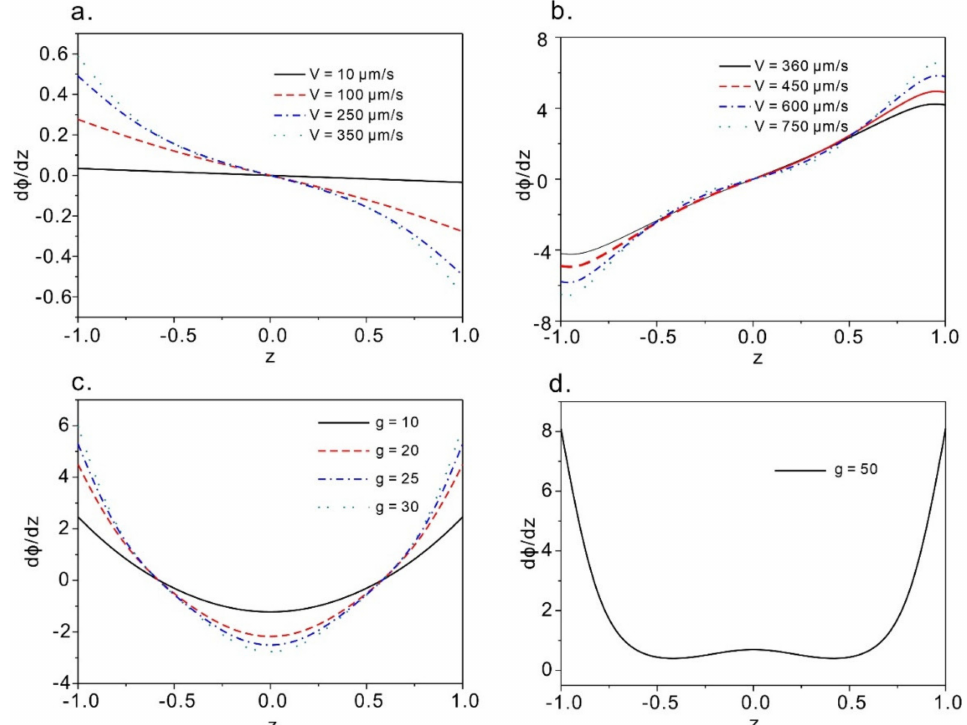
Figure 8. Positional sensitivity of the directional profile of the LC flow. ( a ) and ( b ) are sensitivities of the LC in Couette flow at various velocities of the upper plate; ( c ) and ( d ) represent the sensitivities at various dimensional pressure gradient in Poiseuille